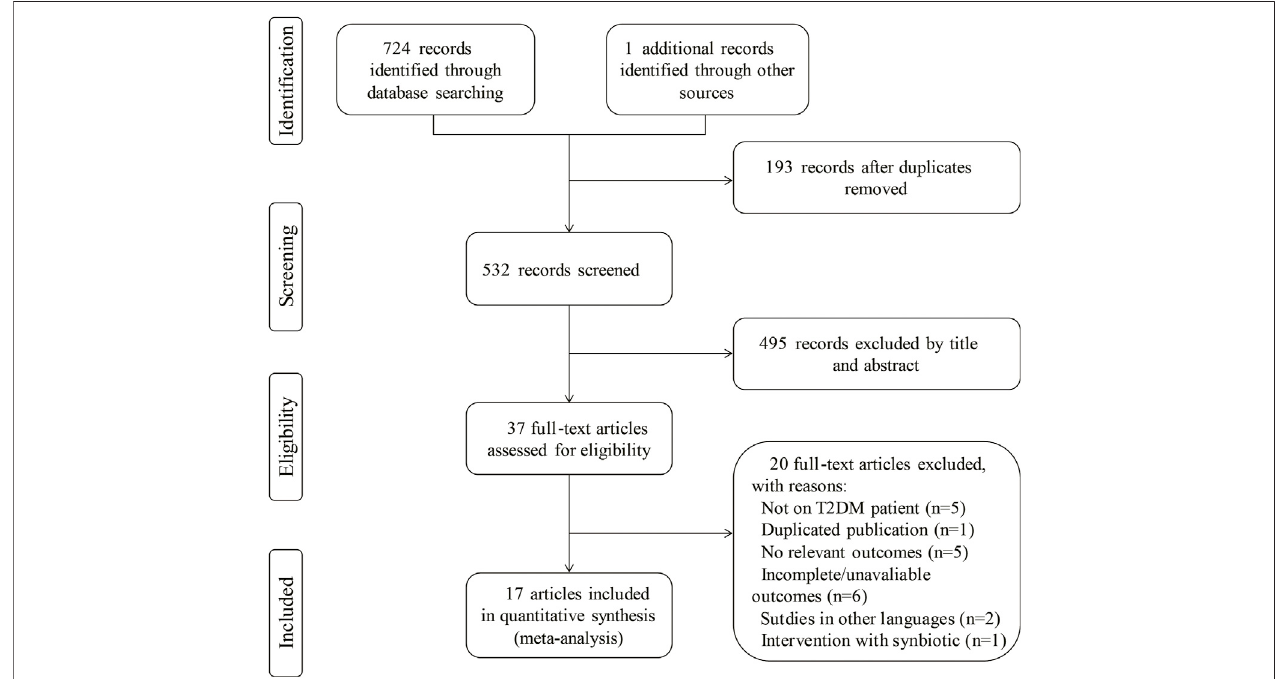
FIGURE 2 | Study fl ow diagram for study